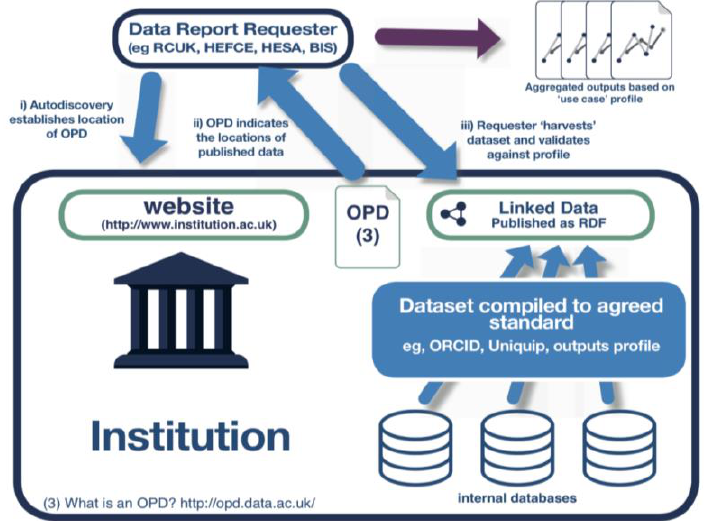
Figure 1. Simple model for data discovery using the OPD. Source: Abstract from poster submitted to Research Data Alliance 5th Plenary, San Diego [16]. Copyright: Adrian J. M. Cox, University of Southampton, 2015.